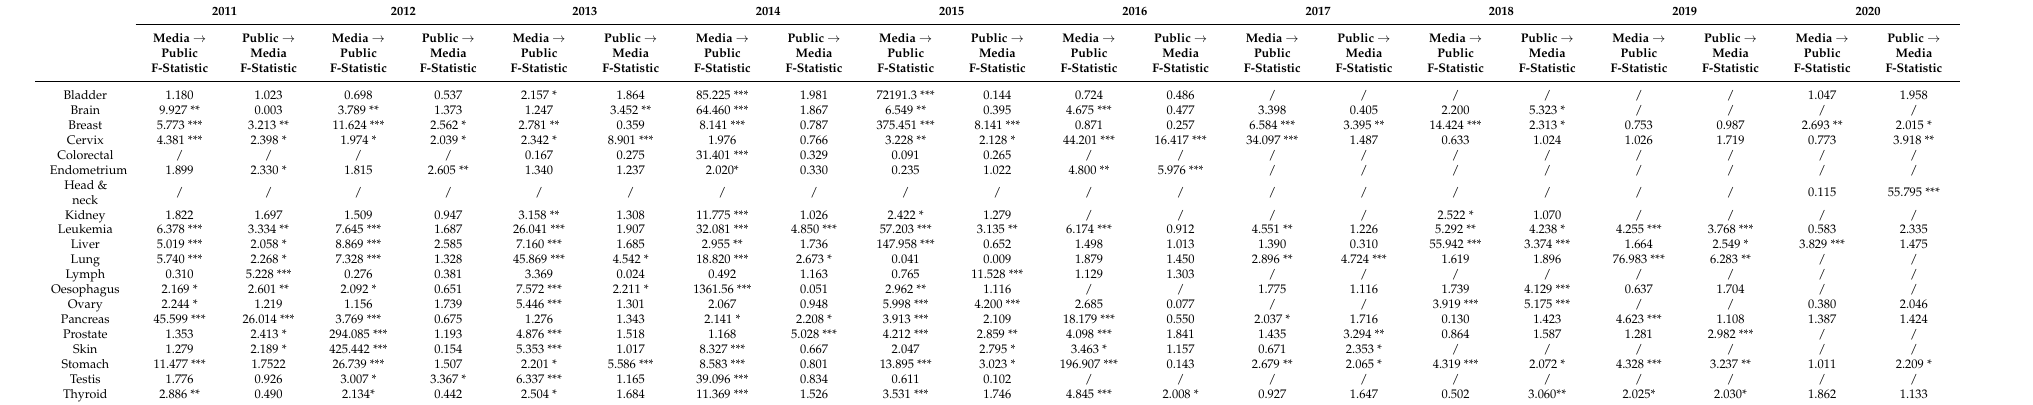
Table 3. The Granger causality results